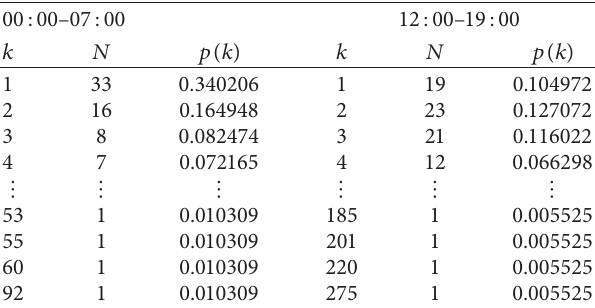
Figure 11: Simulated value of I ( t ) , S ( t ) , and R ( t ) by the ASIRS model. Table 7: Airport degree